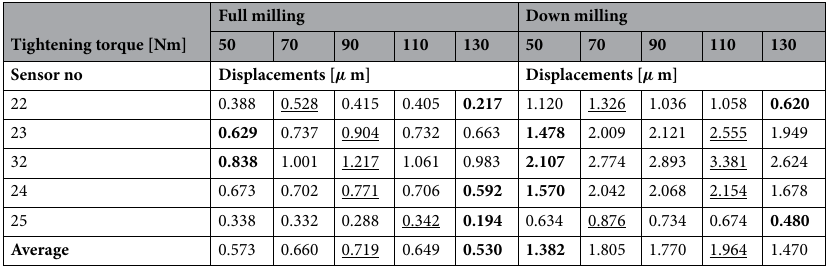
Table 2. RMS values of the vibrations’ displacements during full and down milling of surface 1 for different fixing conditions. Best results are shown in bold, but adverse results are